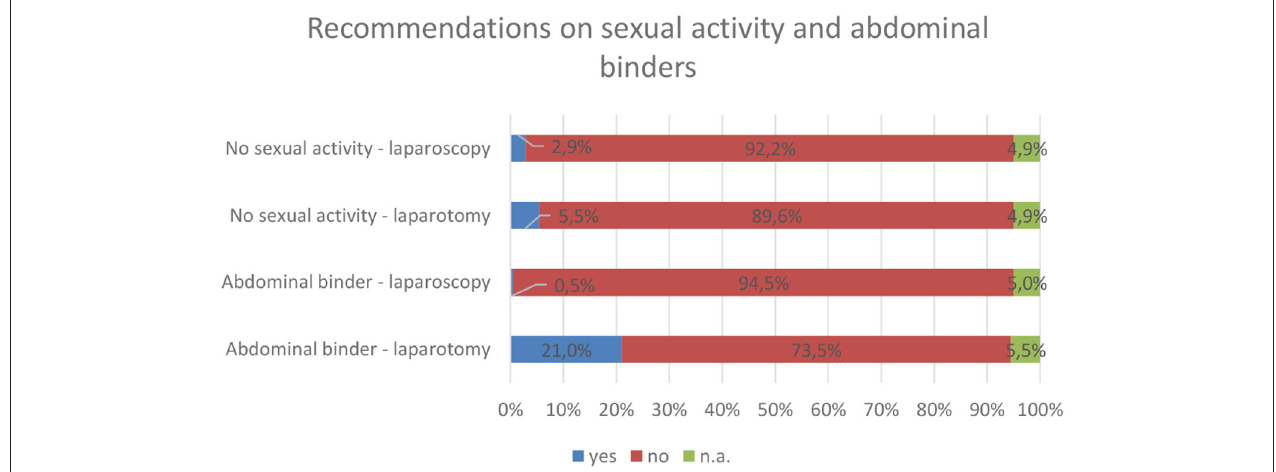
FIGURE 4 | Overview of recommendations on abdominal binders and sexual activity. Of those who recommend abdominal binders after laparotomy, 20.0% advise patients to wear them for 2 weeks, 23.5% for 4 weeks, and 27.2% for 6 weeks. n.a., not